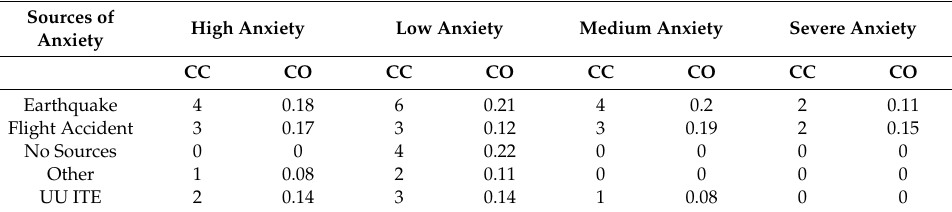
Table 20. Co-occurrences and sources of